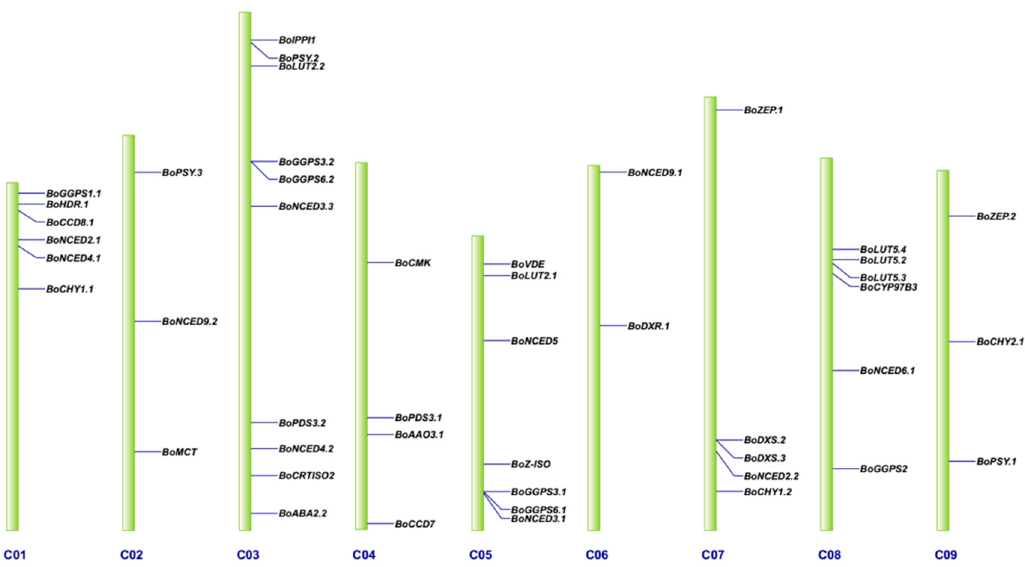
Figure 2. Genomic localization of the carotenoid biosynthetic genes on the nine chromosomes of B. oleracea . C01 to C09 indicate B. oleracea chromosomes.